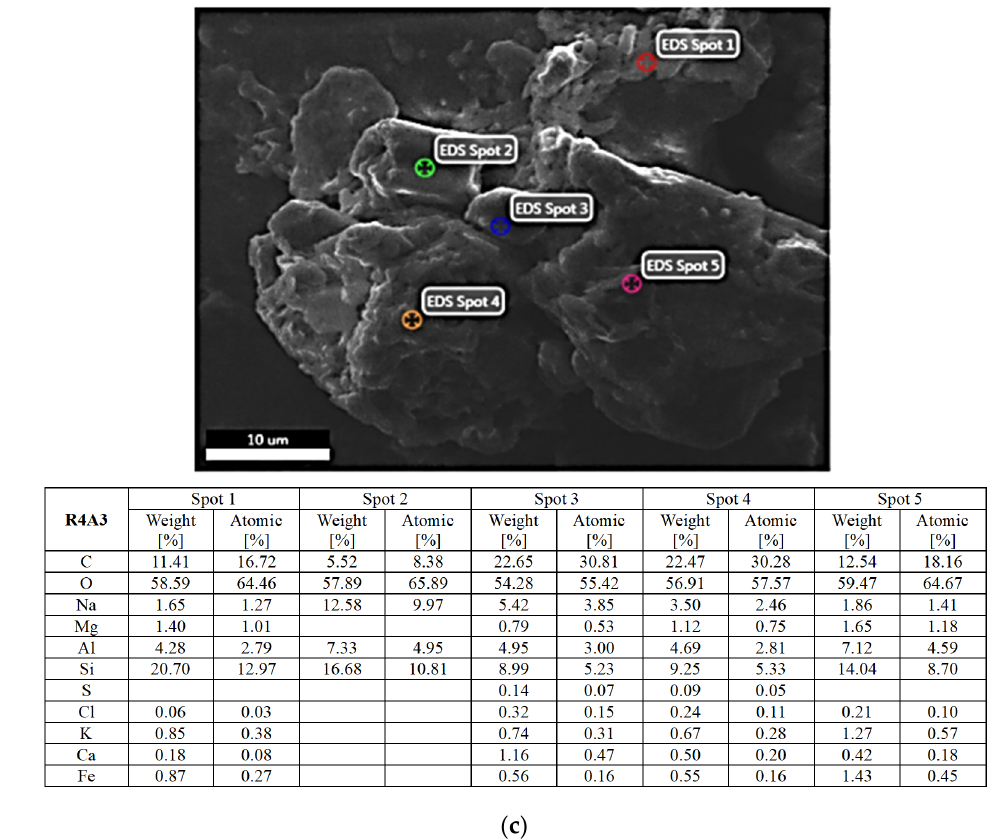
Figure 10. Report 4 of SEM-EDS results of analyzed areas of dry material decanted from rainwater: Figure 10. Report 1 of SEM-EDS results of analyzed areas of dry material decanted from rainwater: ( a ) R4A1; ( b ) R4A2; ( c ) R4A3. ( a ) R1A1; ( b ) R1A2; ( c )